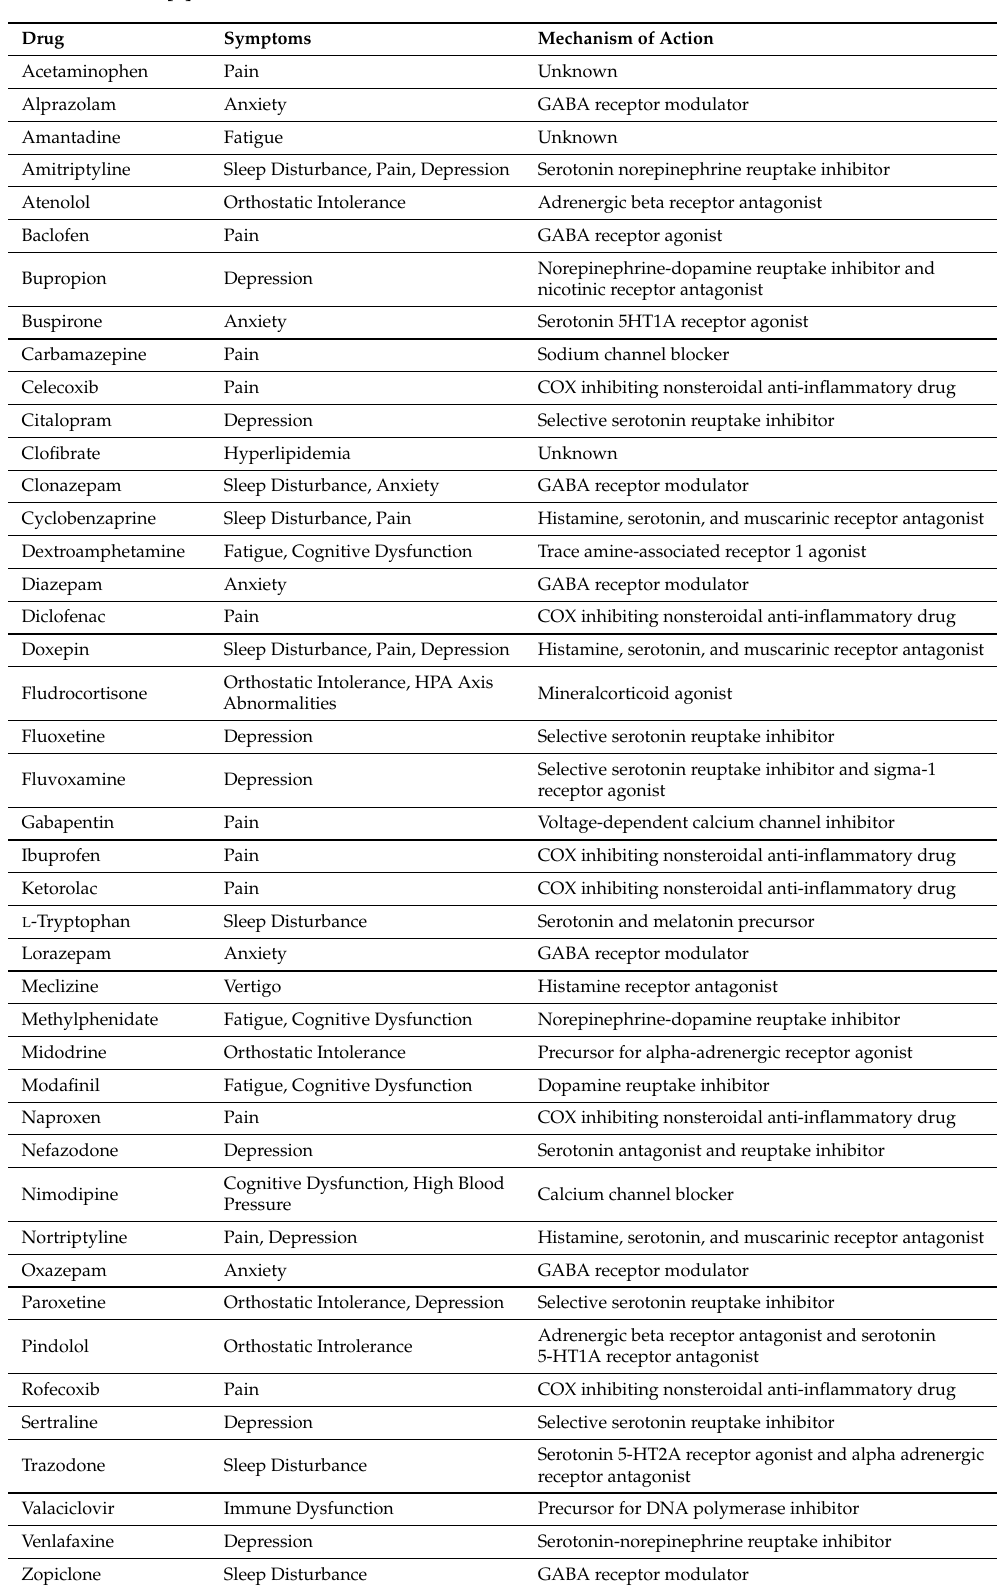
Table 1. Drugs commonly used to treat Gulf War Illness (GWI) symptoms. Adapted from Carruthers et al.